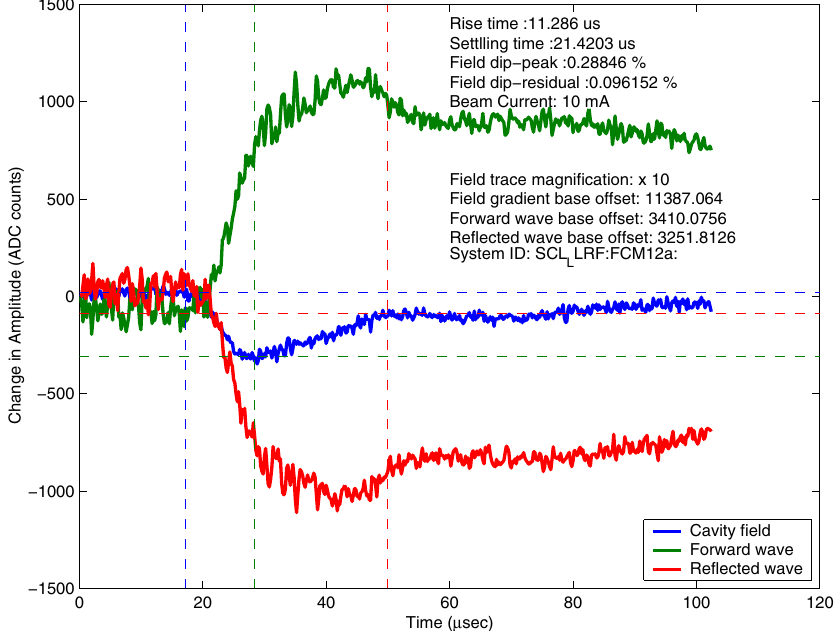
FIG. 9. (Color) A detailed view of the FCM transient response to a 10 mA, 300 (cid:1) s beam on superconducting cavity SCL-12a. The cavity field trace is magnified by an extra factor of 10 so that the beam loading becomes